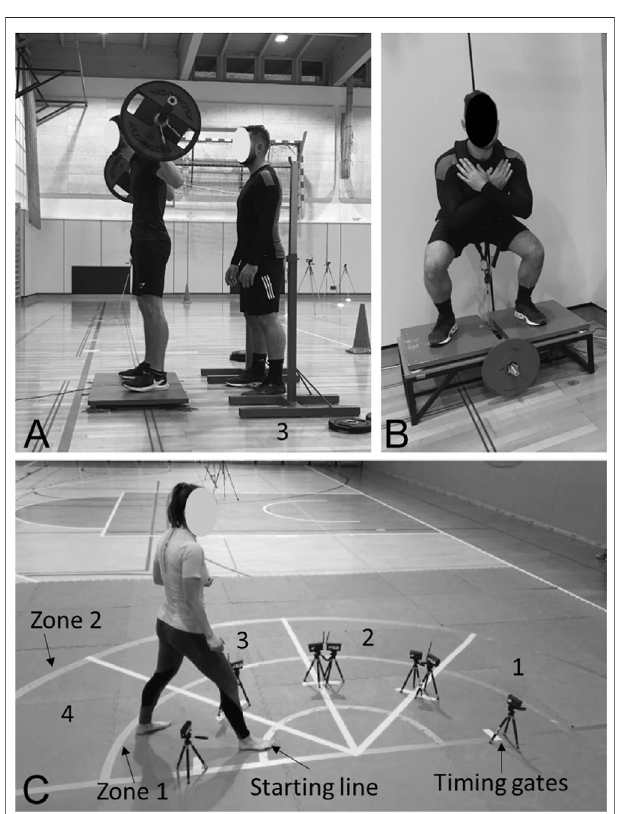
FIGURE 1 | Measurement set-up for counter movement jumps (A) , fl ywheel squats (B) and karate speci fi c test (C) .